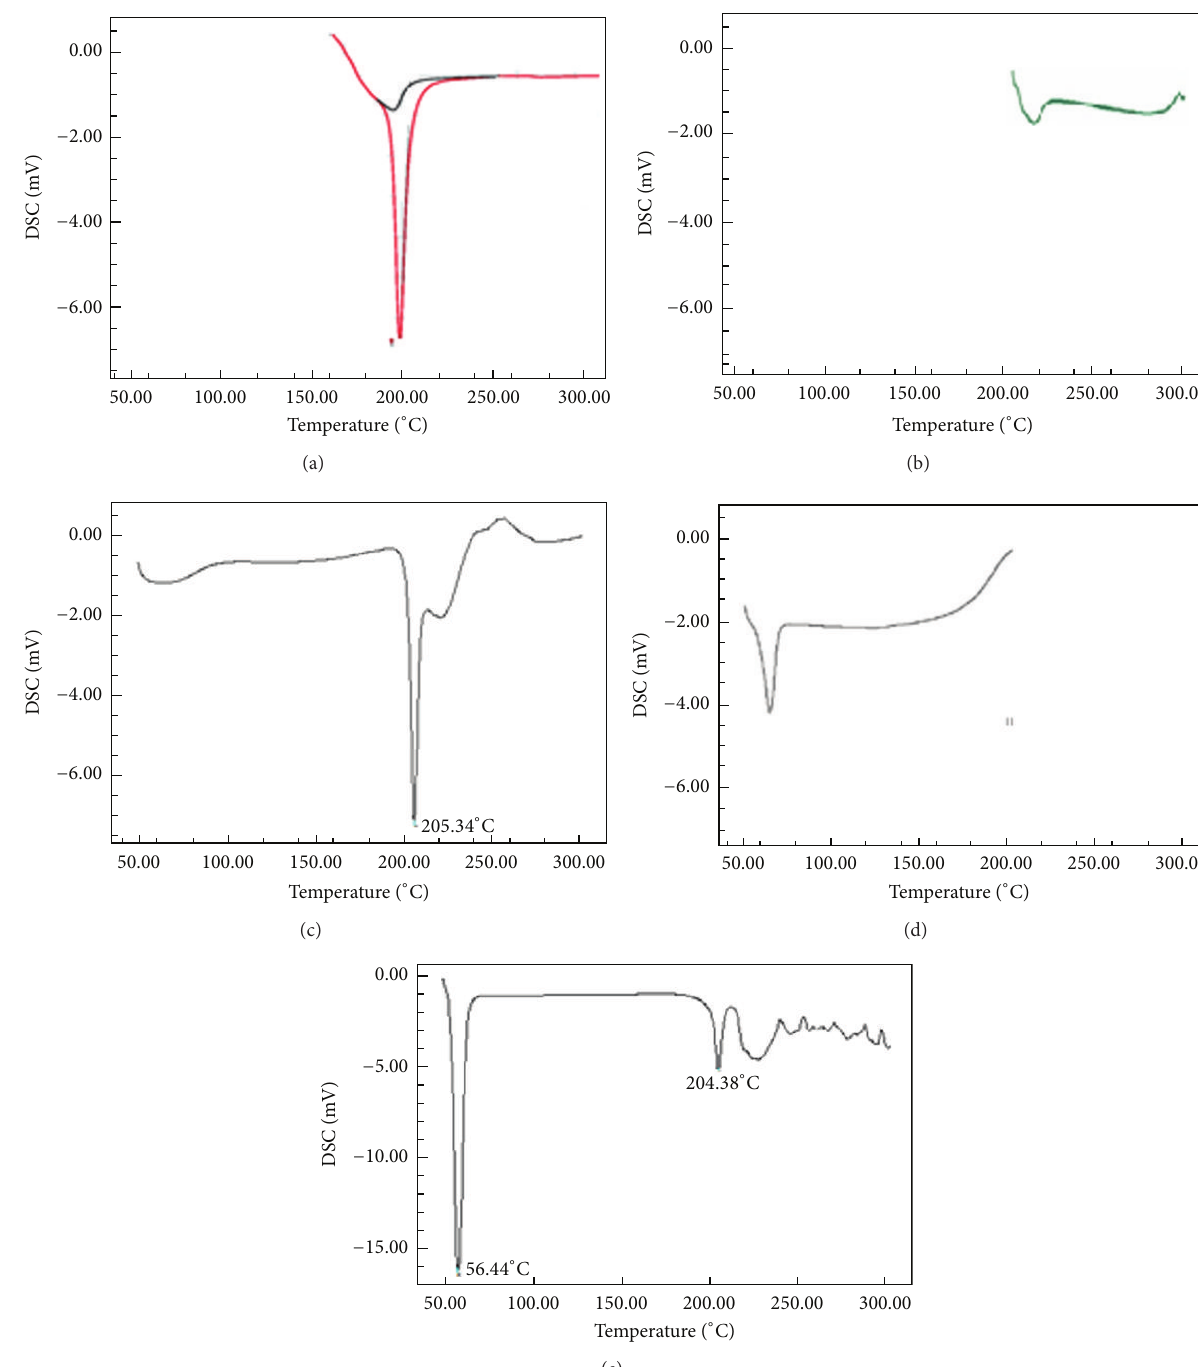
Figure 3: (a) DSC thermogram of pure drug, (b) pure HPMC, (c) drug + HPMC, (d) Poloxamer 407, and (e) drug + Poloxamer 407.